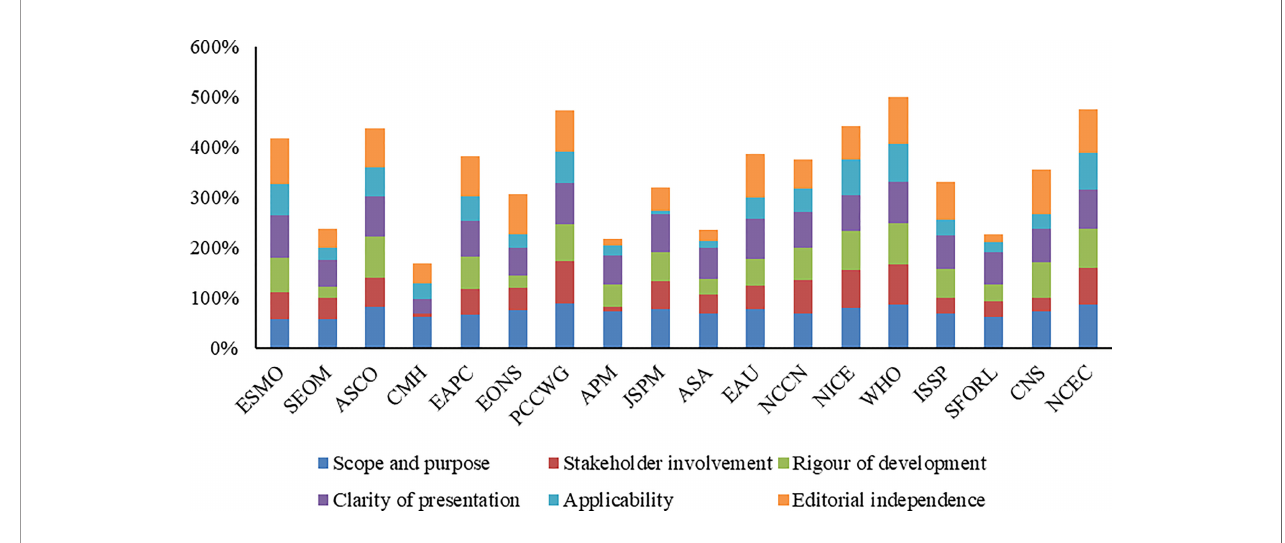
FIGURE 2 | Total AGREE II score by domain across 18